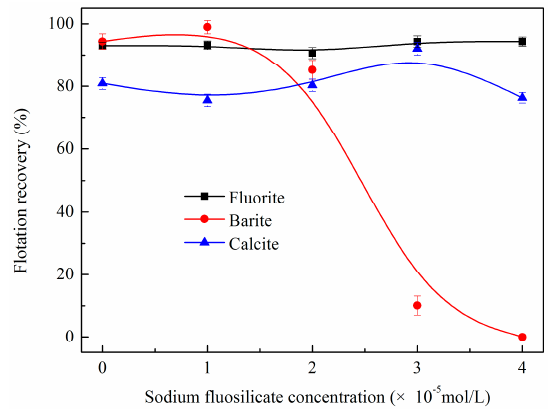
Figure 5. Effects of sodium fluosilicate dosage on flotation recovery (sodium oleate dosage = 4 × 10 − 5 mol/L, pH = 7).